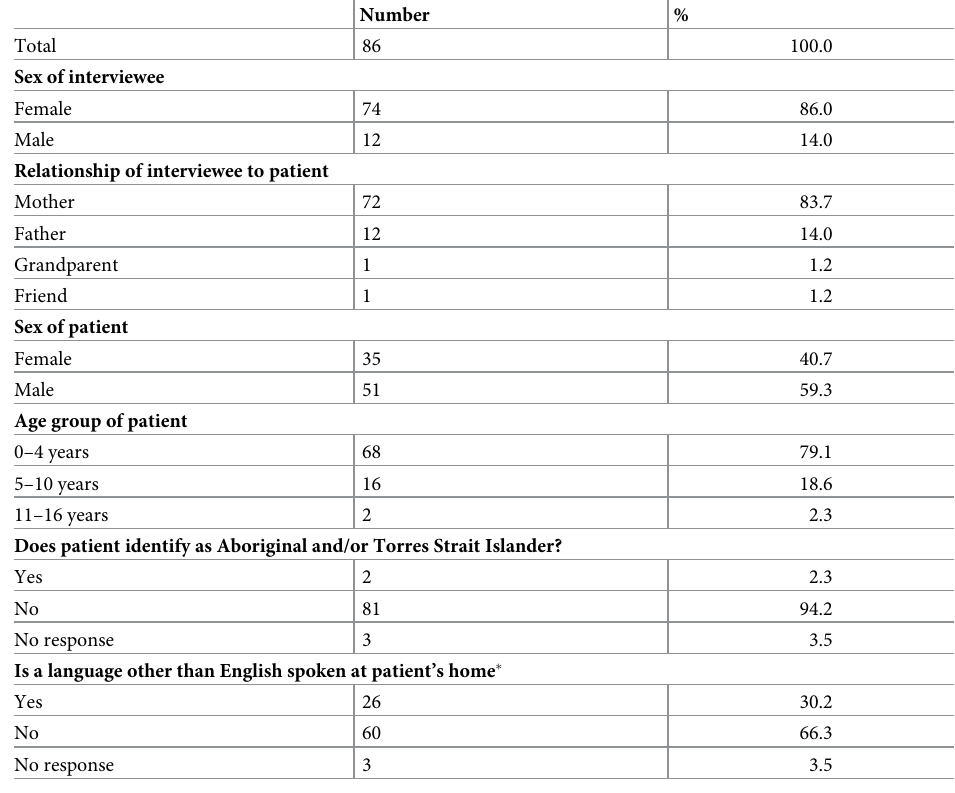
Table 2. Characteristics of interviewees and patients who experienced a drowning-related hospitalisation whose parents/caregivers were interviewed for the